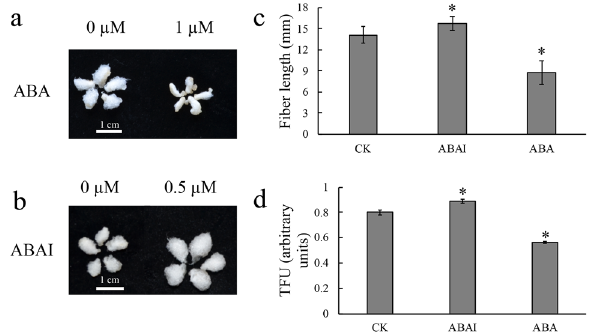
Figure 1. The 0 DPA ovules were cultured in BT medium with ABA and ABAI for 20 days. ( a , b ) Phenotypes of cotton ovules under ABA or ABAI treatment. Bar = 1 cm. ( c ) Fiber length on the cultured ovules in different treatments. ( d ) Total fiber units on cultured ovules under different treatments. *Indicates a significant difference with p < 0.05 using a t test